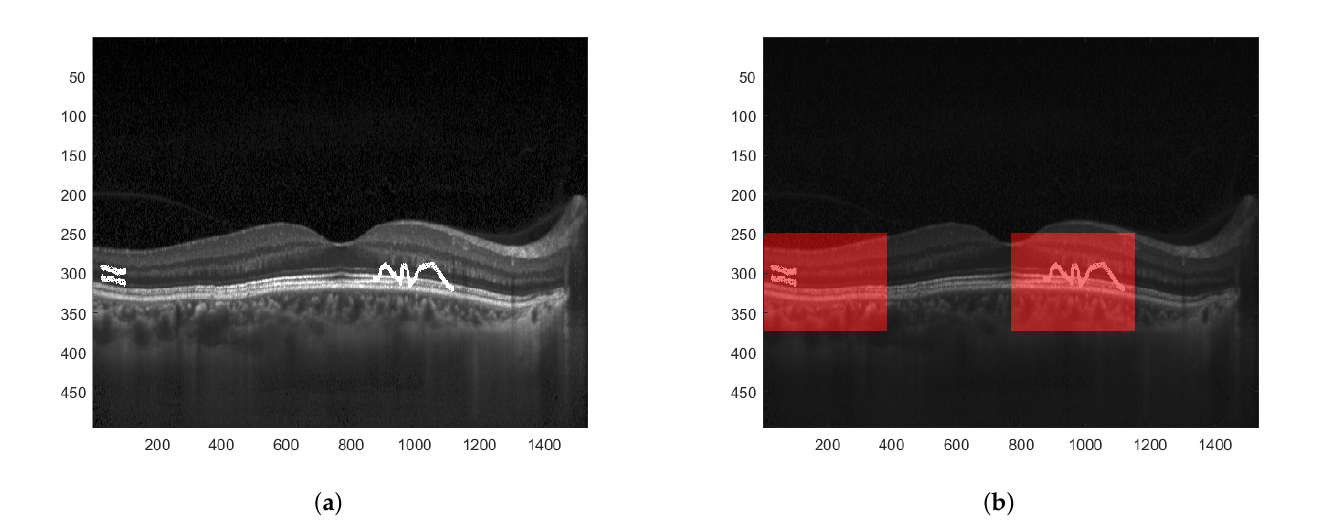
Figure 8. Result of image manipulation detection. ( a ) Tampered watermarked image. ( b ) Detected regions where the image has been manipulated.